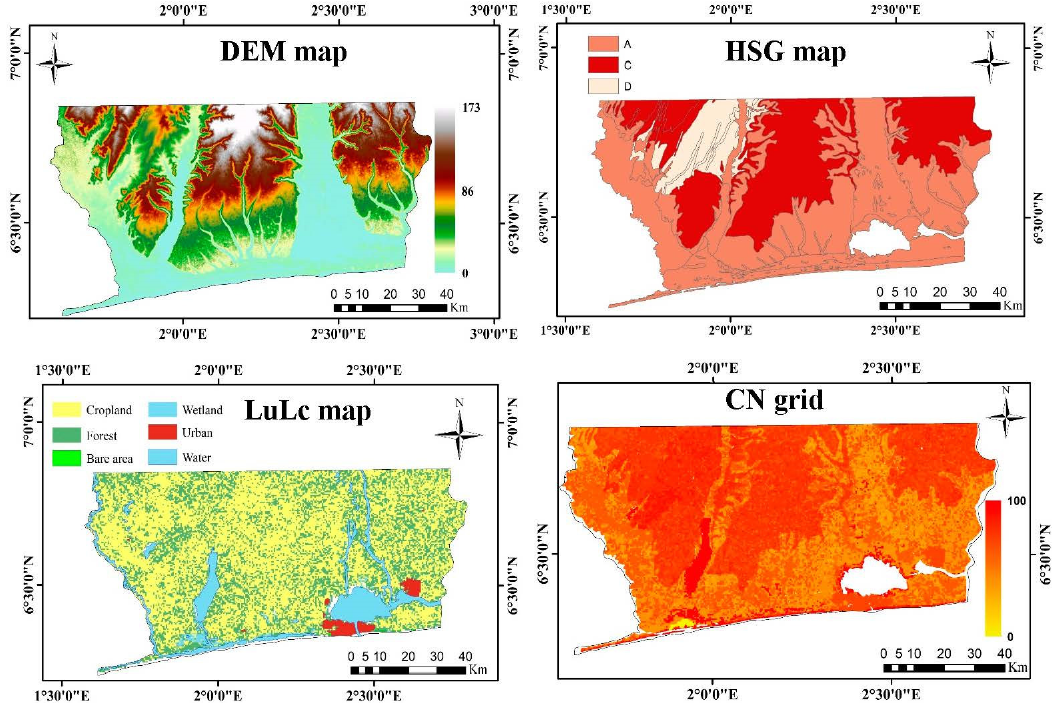
Figure 3. DEM, HSG, LuLc and generated CN grid map used to estimate groundwater recharge within the study region.